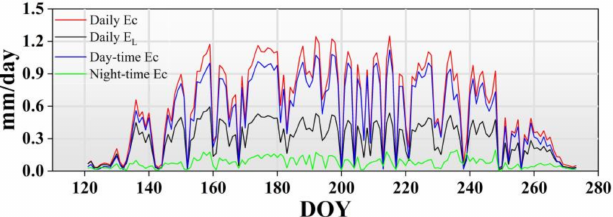
Figure 5. Plot showing the daily dynamics of transpiration in growing season. DOY refers to day of the